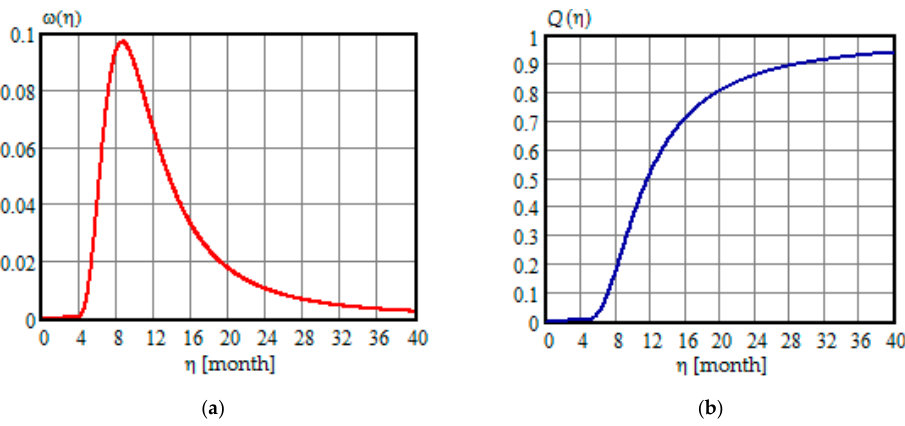
Figure 4. ( a ) The plot of the conditional probability density function (PDF) of the error in evaluating the time to failure when η = 6 months ; ( b ) The plot of the PDF of the measurement error of sensors.